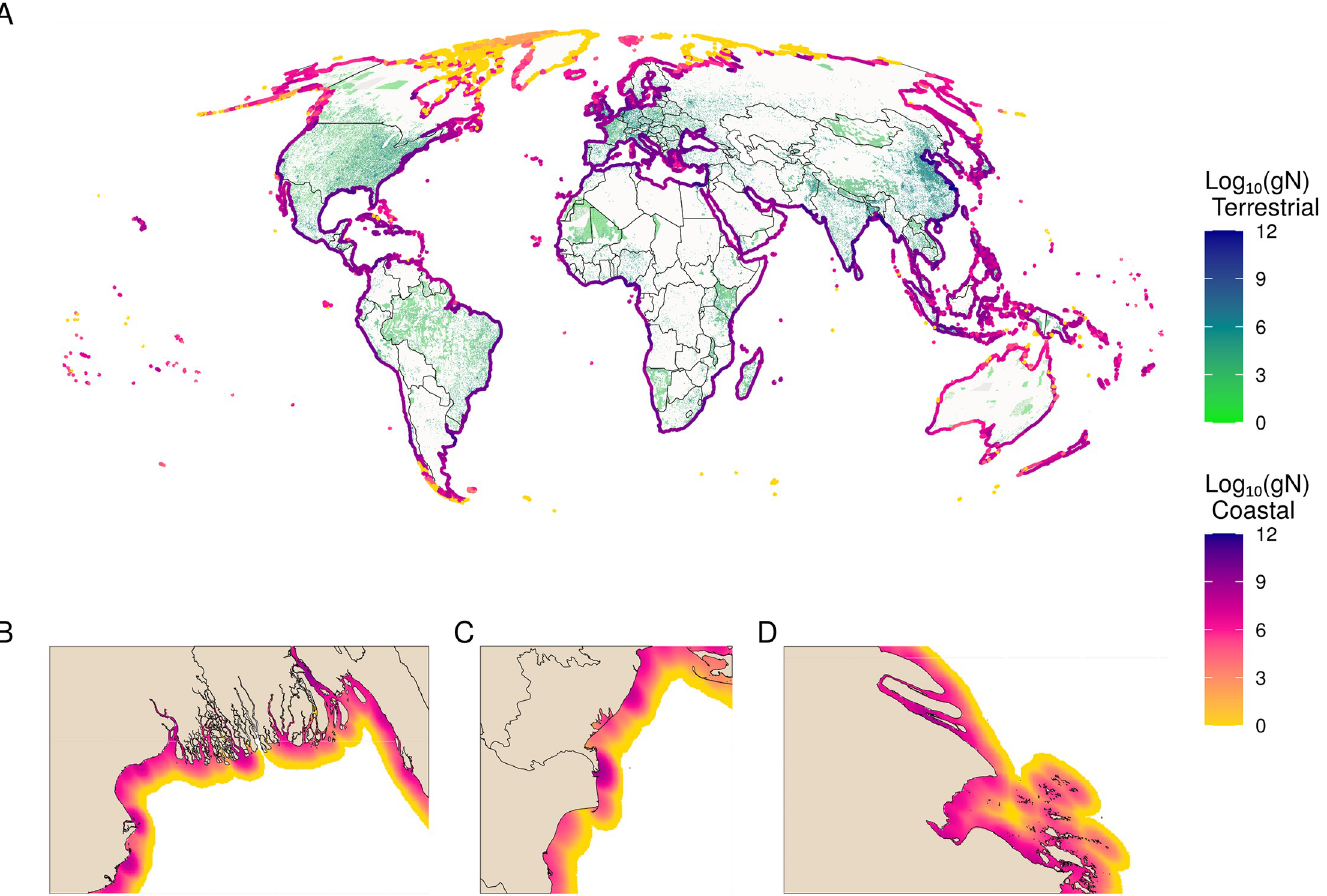
Fig 1. Global distribution of total wastewater N. A) Global map of the terrestrial sources (green to blue) and coastal diffusion of inputs (yellow to purple) of total wastewater N, measured in log10(gN) in both. Coastal plumes have been buffered to line segments to exaggerate patterns to be visible at the global scale. Insets show zoomed-in views of the B) Ganges, C) Danube, and D) Chang Jiang (Yangtze) Rivers, showing wastewater plumes at high resolution.